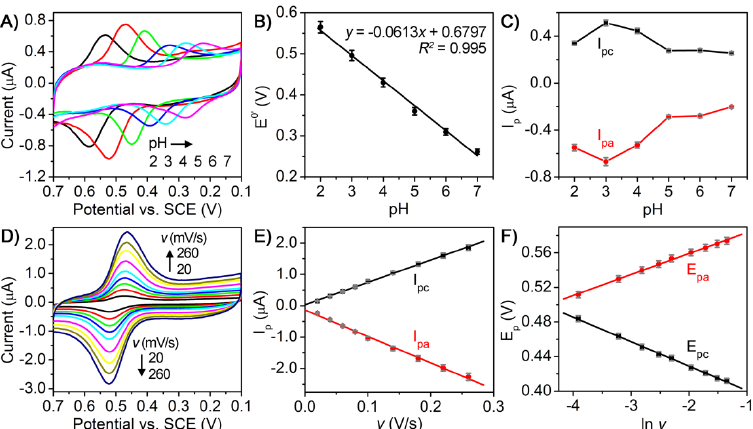
Figure 4. ( A ) Cyclic voltammograms of 1.0 μ M luteolin on AuNCs/CILE in PBS with different pH values (2, 3, 4, 5, 6, 7) at a scan rate of 100 mV/s; ( B ) Relationship between E 0 ′ and pH; ( C ) Relationship between I p and pH; ( D ) Cyclic voltammograms of 1.0 μ M luteolin on AuNCs/CILE in 0.1 M PBS (pH = 3) at different scan rates ( v ; 20, 40, 60, 80, 100, 140, 180, 220, 260 mV/s); ( E ) Linear relationship between I p and v ; ( F ) Linear relationship between E p and ln v .